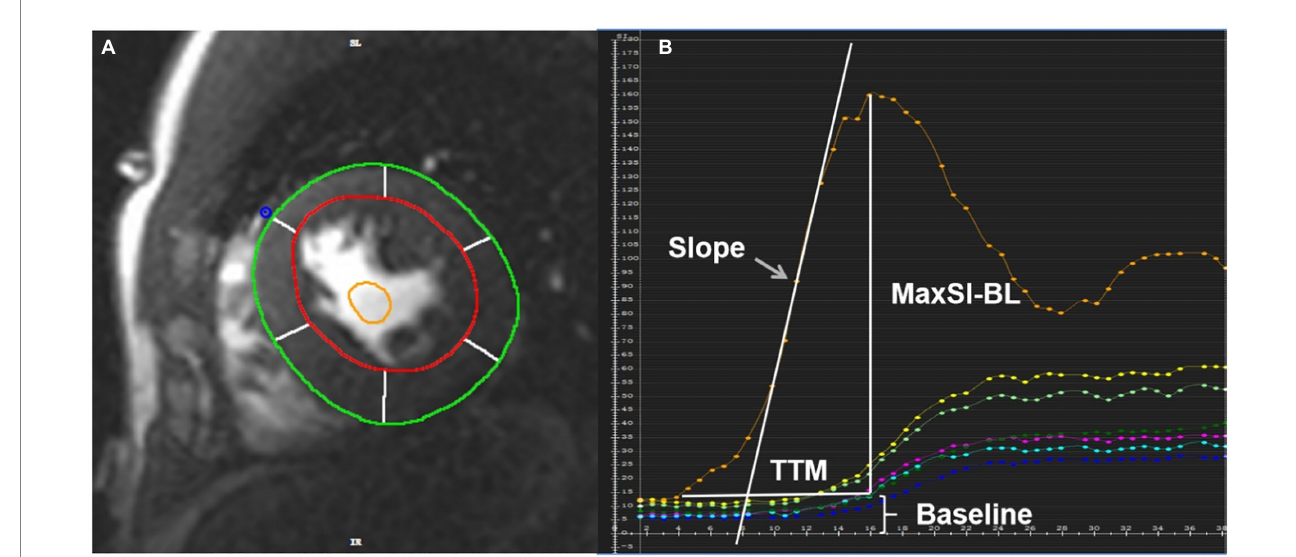
FIGURE 1 (A) The region of interest of the rest first-pass images was plotted in the middle myocardium. The red circle represented the LV endocardial contour with trabeculation and papillary muscles excluded, the green circle represented the LV epicardial contour, the yellow circle represented the blood pool contour. (B) Slope, TTM, MaxSI and baseline signal intensity can be obtained from the time-signal intensity curve of myocardium and blood pool. The orange curve represents blood pool signal, and the others represent myocardial signal. TTM, time to maximum signal intensity; MaxSI, maximal signal intensity; MaxSI-BL, maximal signal intensity subtracting baseline signal intensity.